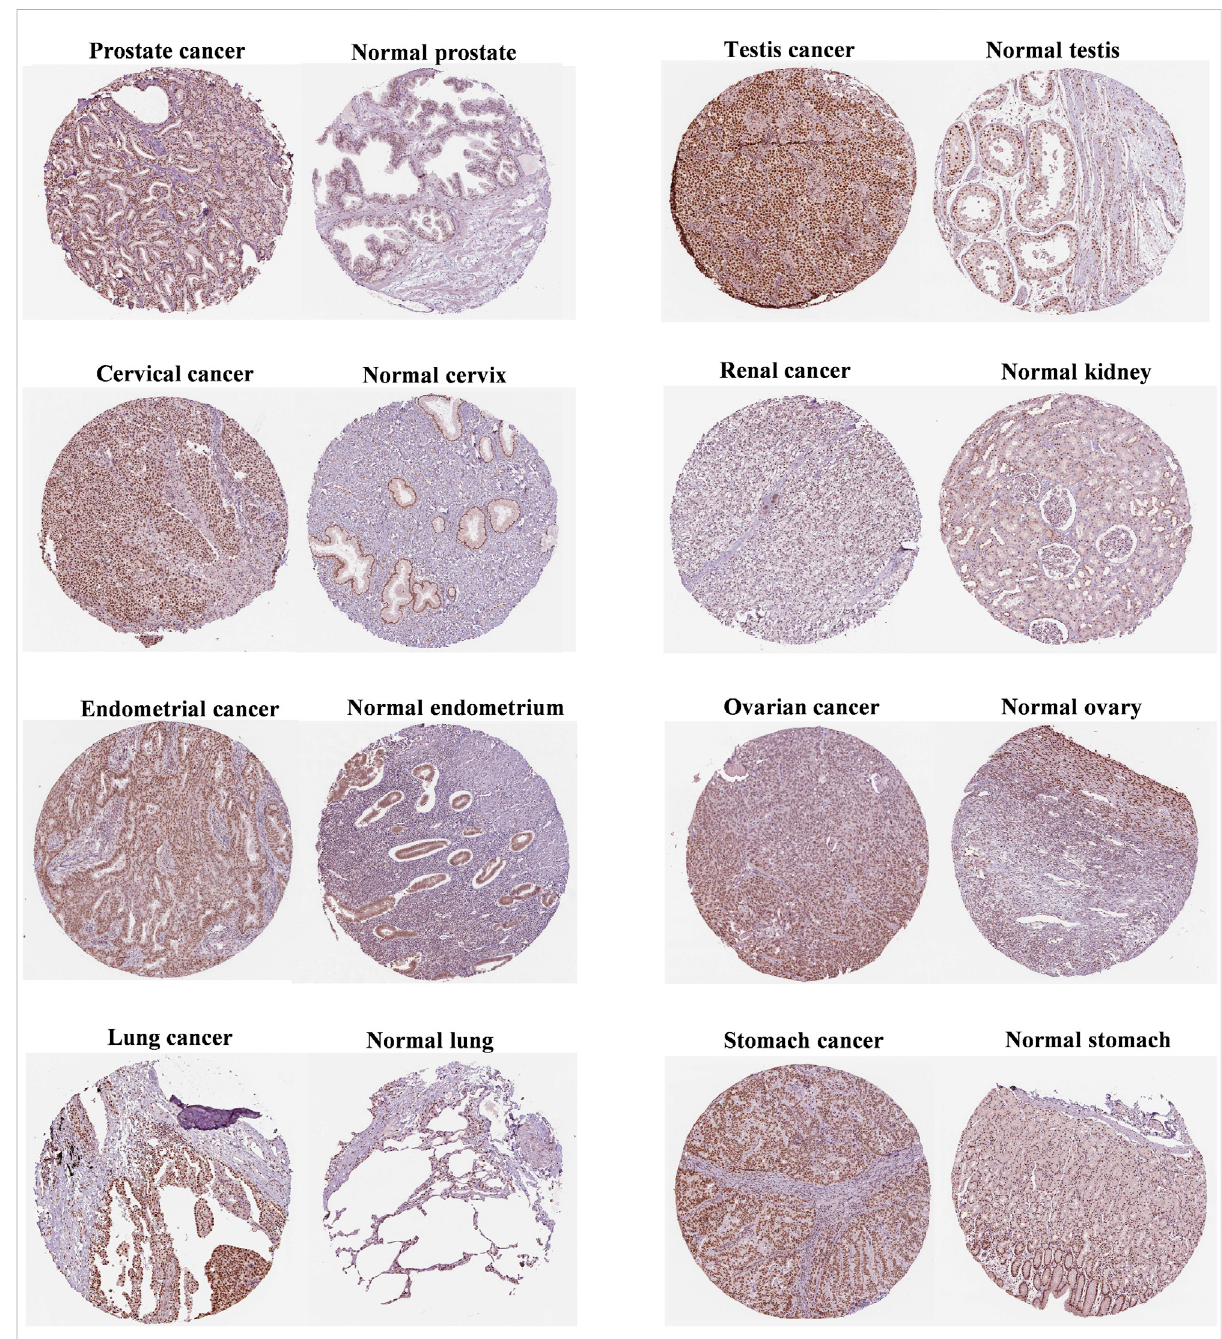
FIGURE 2 Immunohistochemistry of FANCE protein expression between tumor and normal tissues from the Human Protein Atlas (HPA)